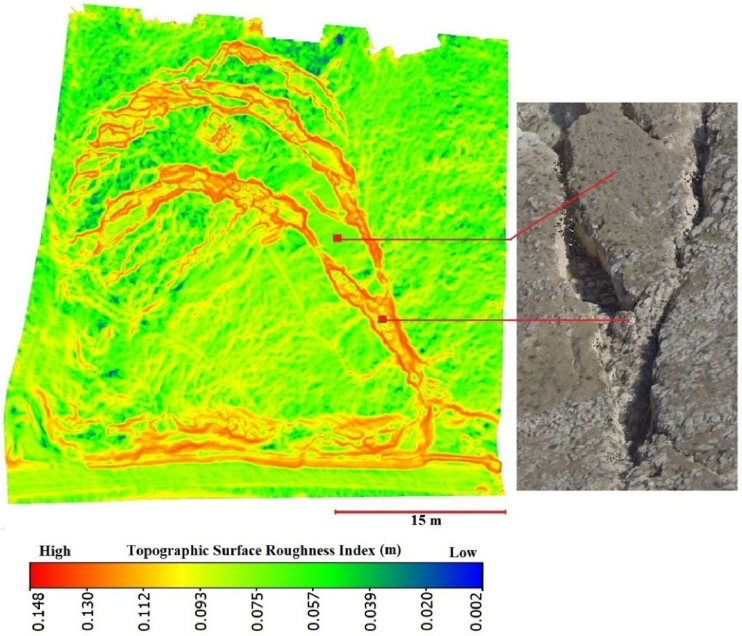
Figure 22. Topographic surface roughness index map of the creeping Salhoub/Al-Juaidieh landslide calculated using a 0.5 m moving sampling window in the dense 3D point cloud.